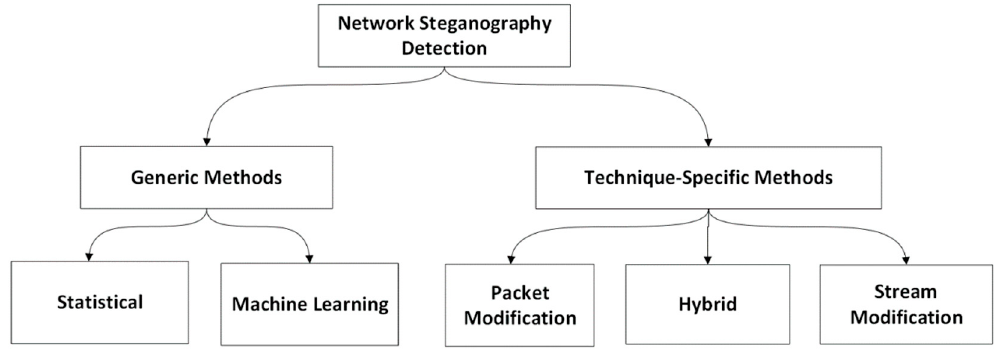
Figure 1. Network steganography detection classification.